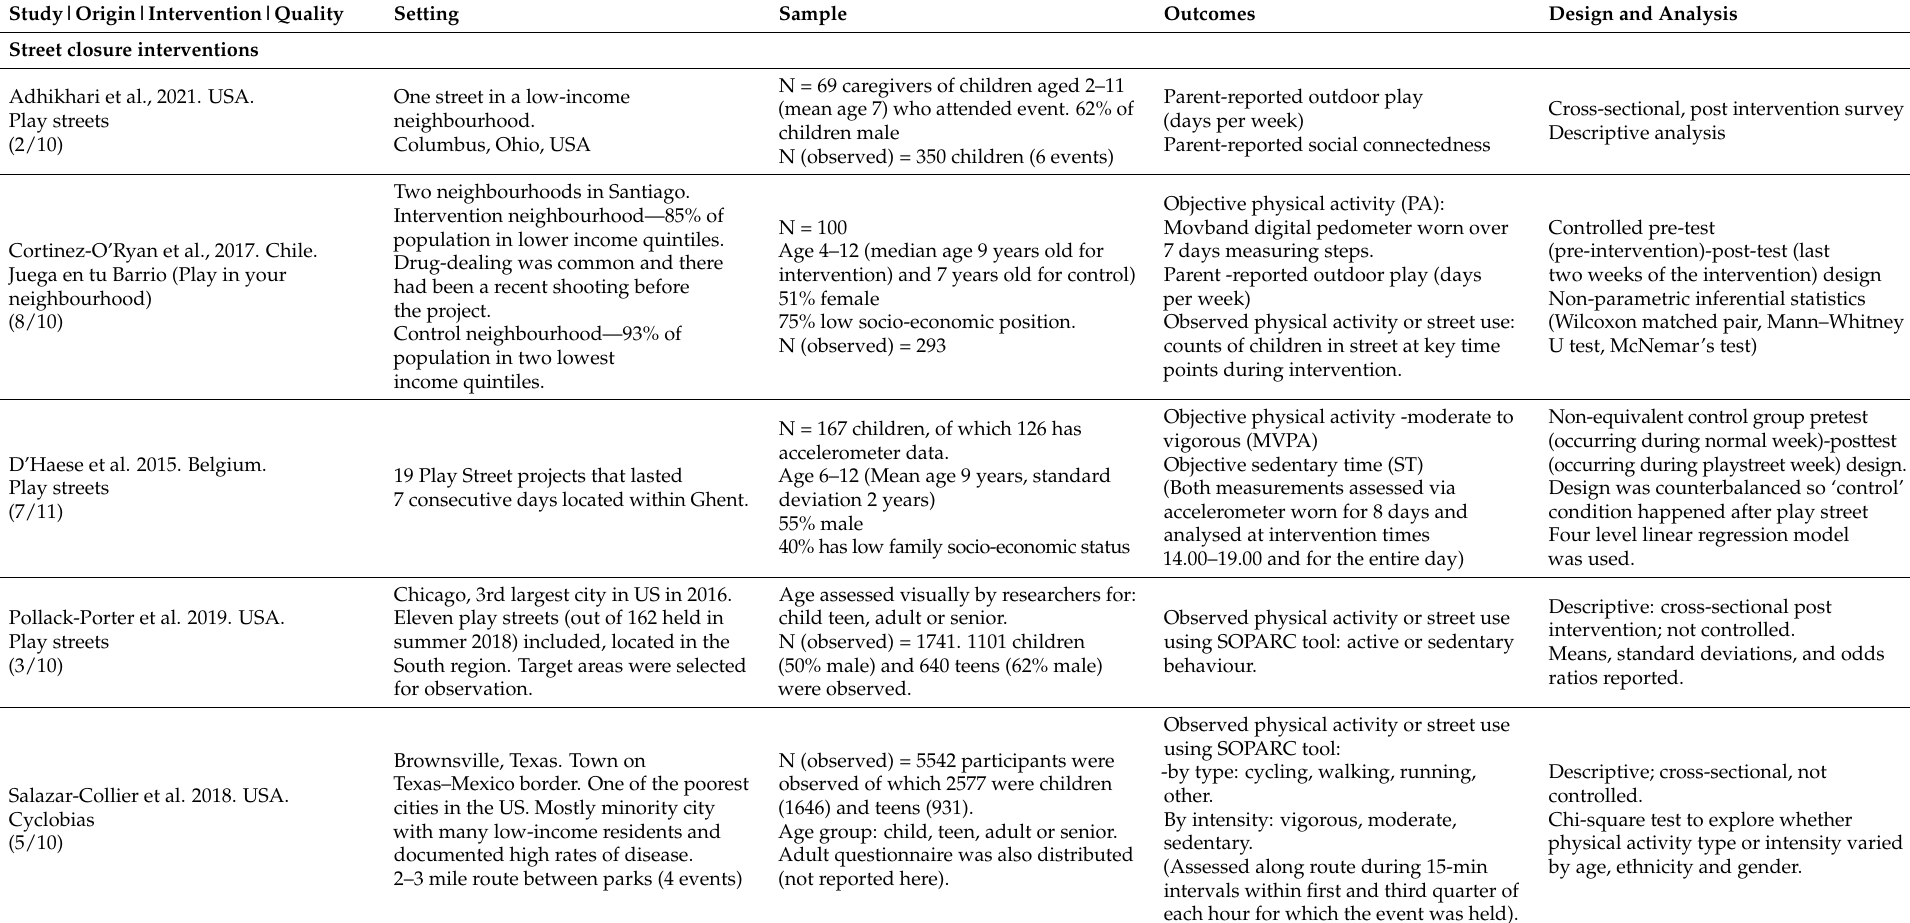
Table 1. Intervention study